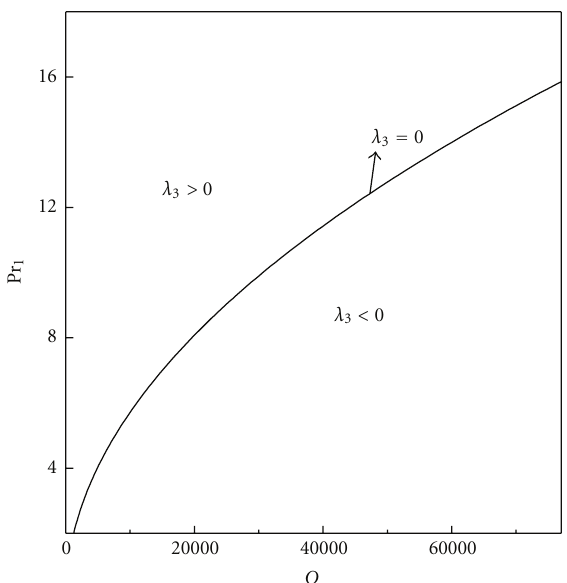
Figure 3: Above figure is plotted for D a = 1500, Λ = 0 . 85, φ = 0 . 9, M = 0 . 9, and Pr 2 = 1 . λ 3 is the nonlinear coe ffi cient of Ginzburg-Landau equation at the onset of stationary convection. The pitchfork bifurcation is supercritical if λ 3 > 0, subcritical if λ 3 < 0 and λ 3 = 0 on the